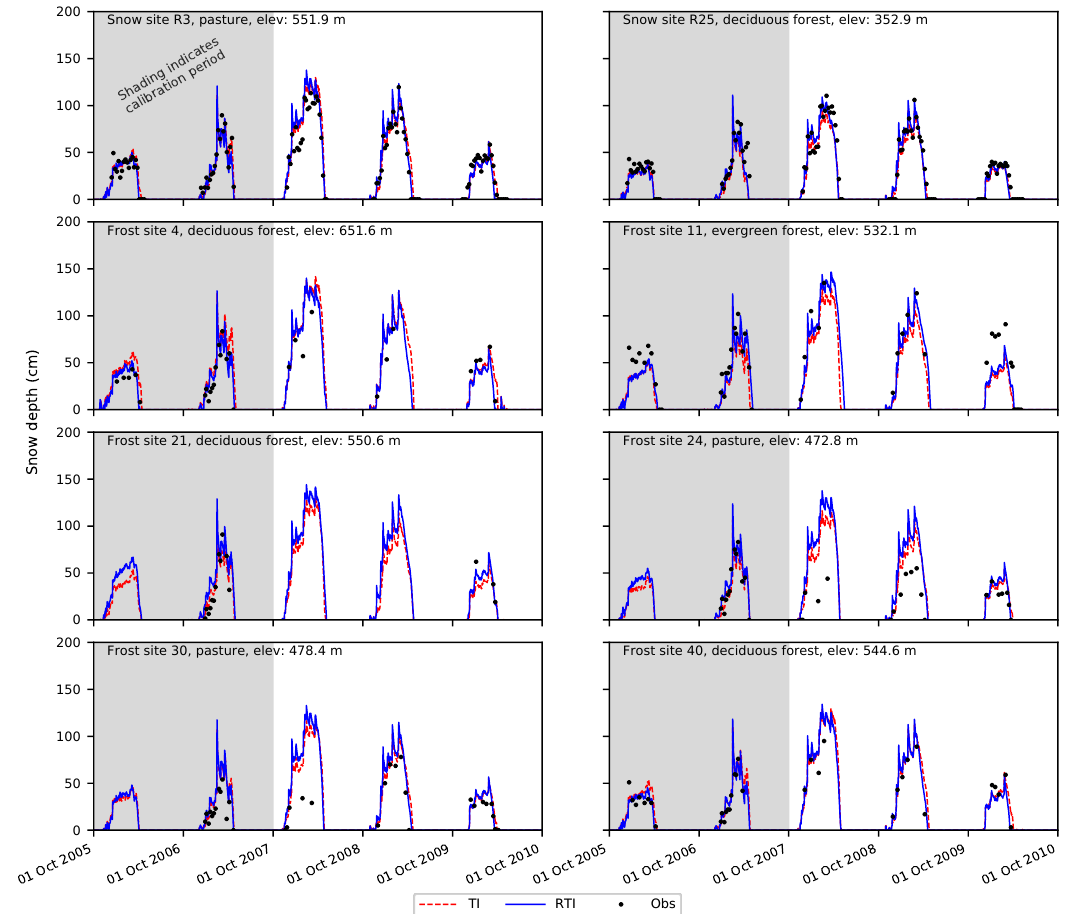
Figure 3. TI and RTI simulated snow depth at all eight test sites within the W-3